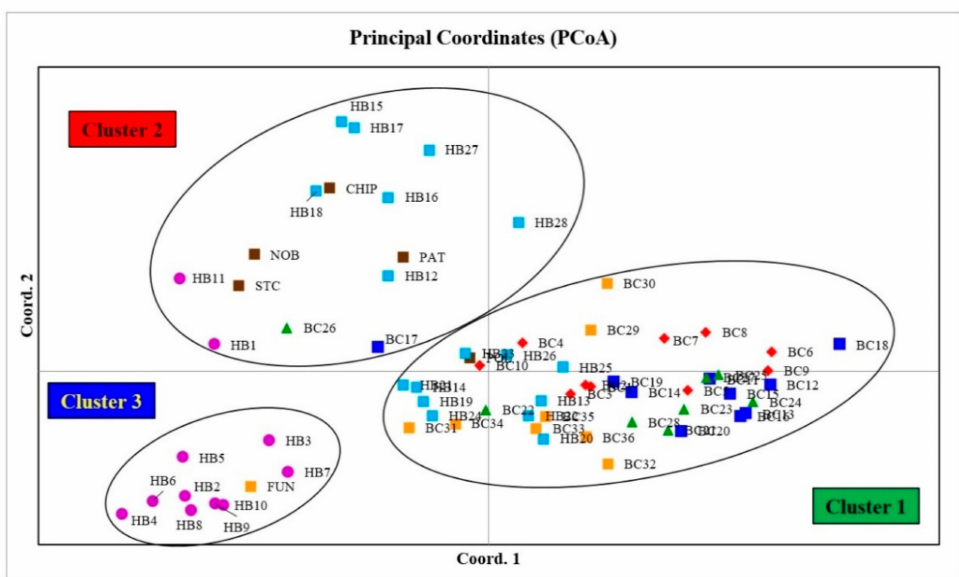
Figure 6. 2D principle coordinate analysis (PCoA) plot of blueberry genotypes using genetic distance matrix produced by the combination of EST-SSR, genomic (G)–SSR and EST-PCR markers. The colour and shape of the points indicate different groups (see Tables 1 and 2 for genotype labels).